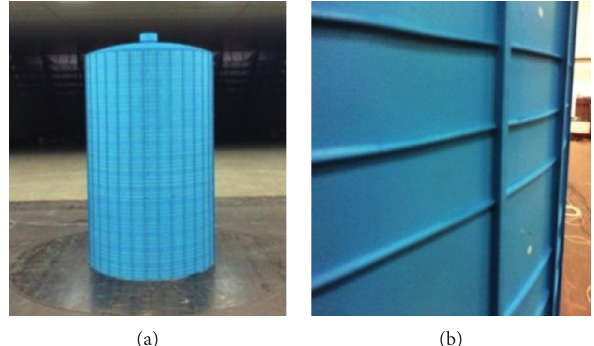
Figure 2: (a) Rigid model of the gas tank. (b) Detailed model surface.